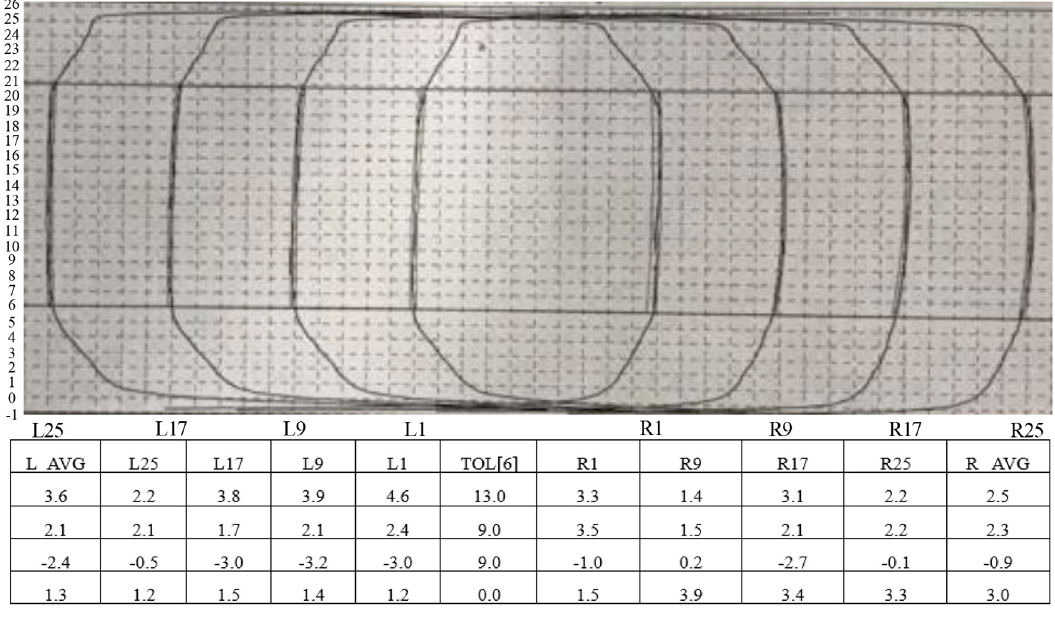
Fig. 7. Helix measurement curve of pinion.